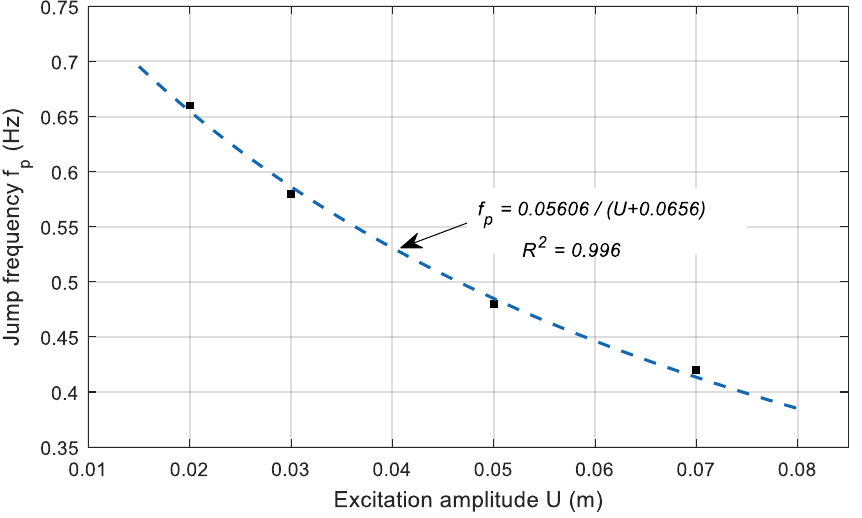
Figure 10. Correlation between the frequency 𝑓 and the parameter √𝑘 𝑀⁄